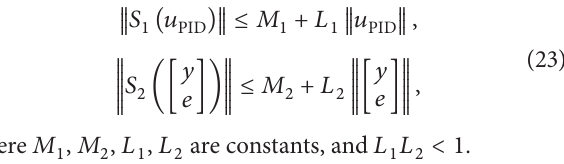
Figure 6: Pneumatic servo control system